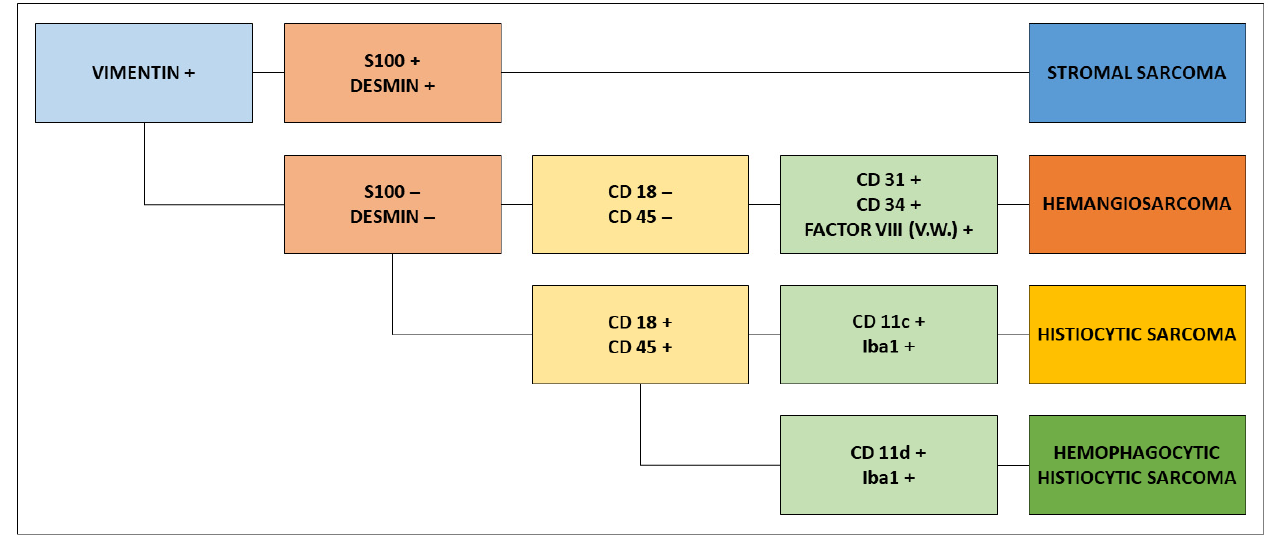
Figure 6. Di ff erential diagnosis algorithm for splenic sarcomas based on immunohistochemical markers.